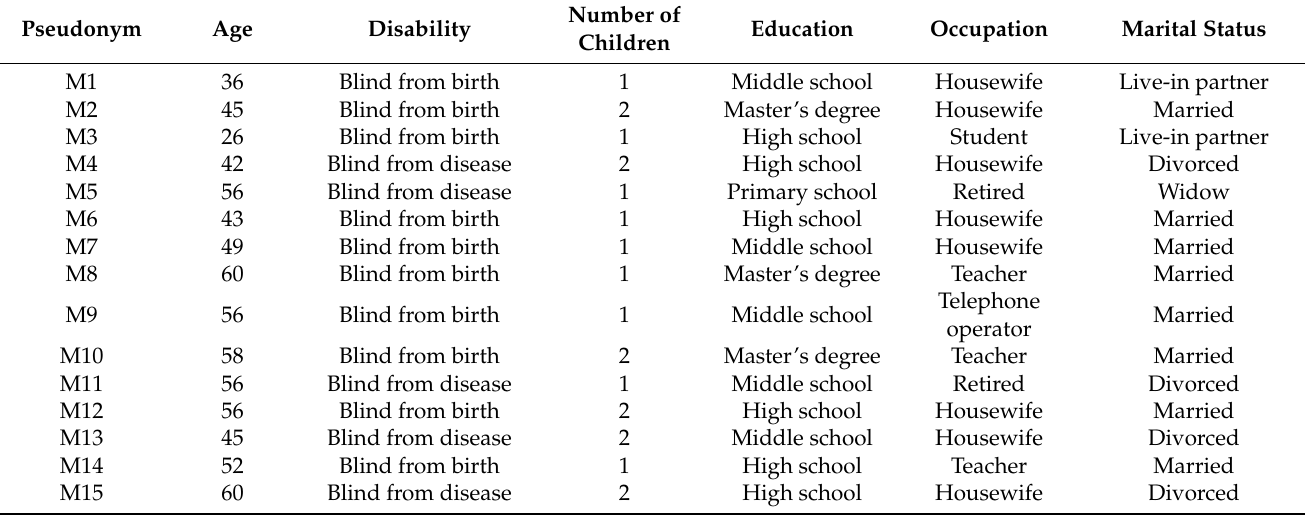
Table 1. Sociodemographic characteristics of the